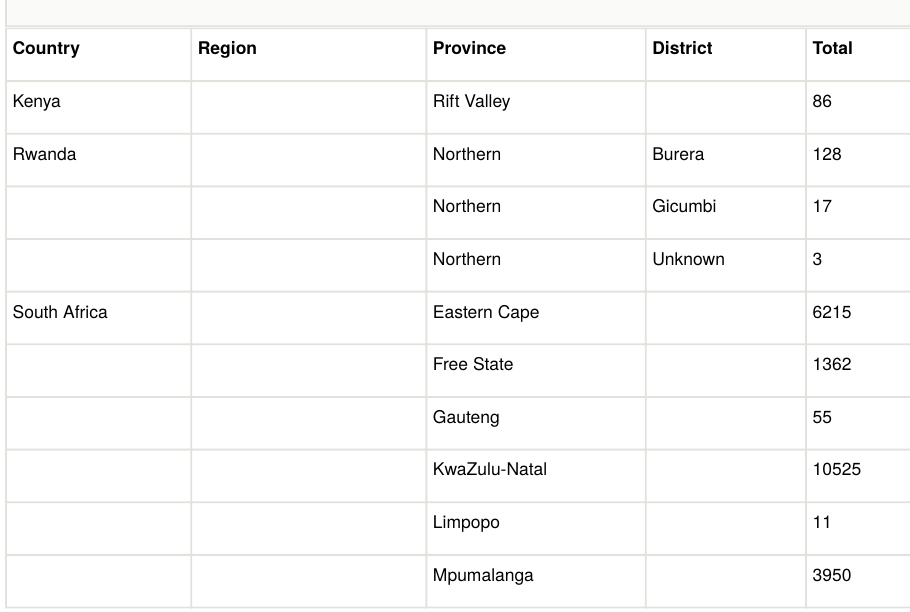
Table 1: The spatial coverage of the dataset - Countries, Provinces and